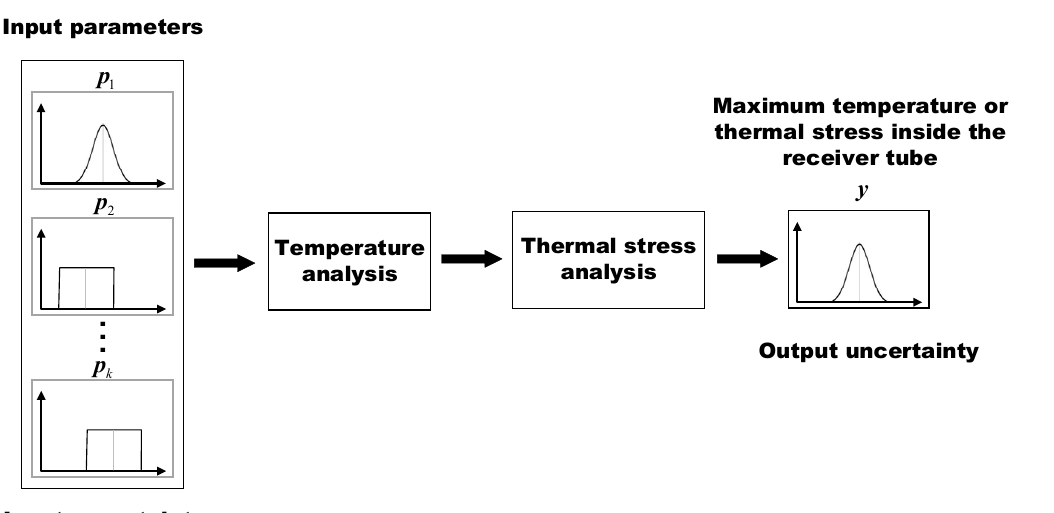
Figure 3. Conceptual representation of uncertainty propagation.